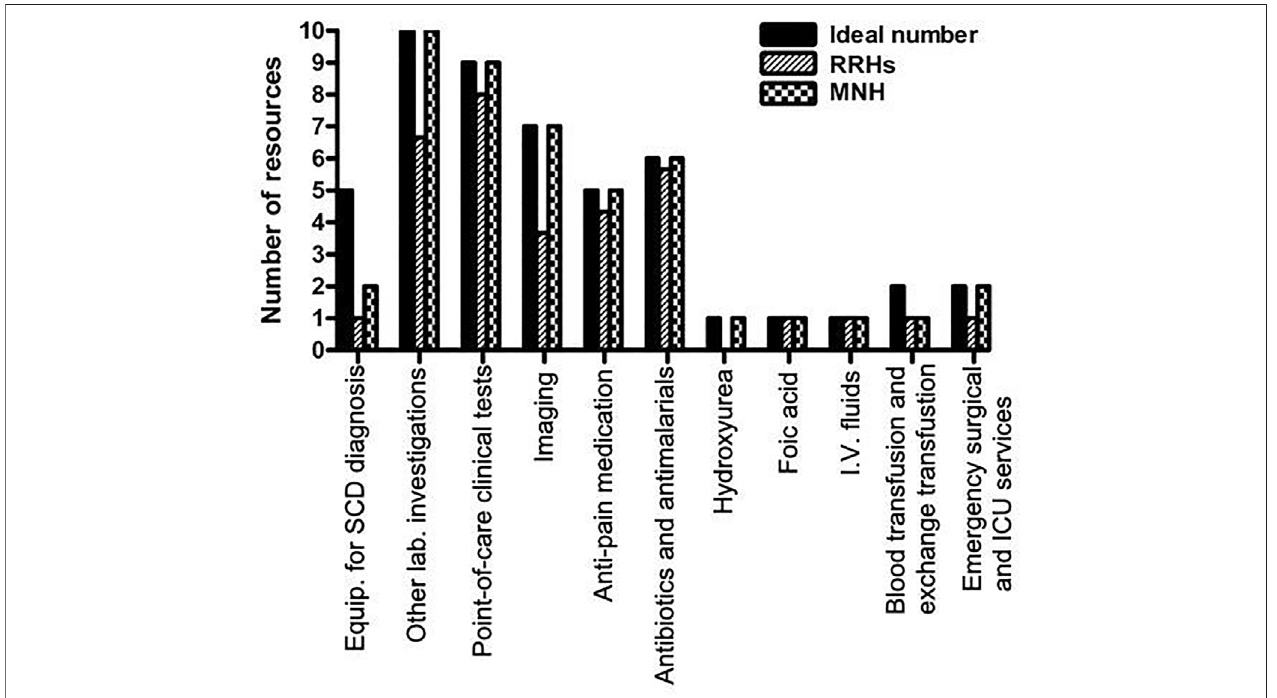
FIGURE 1 | Ideal versus available resources for SCD care at healthcare facilities in Dar es